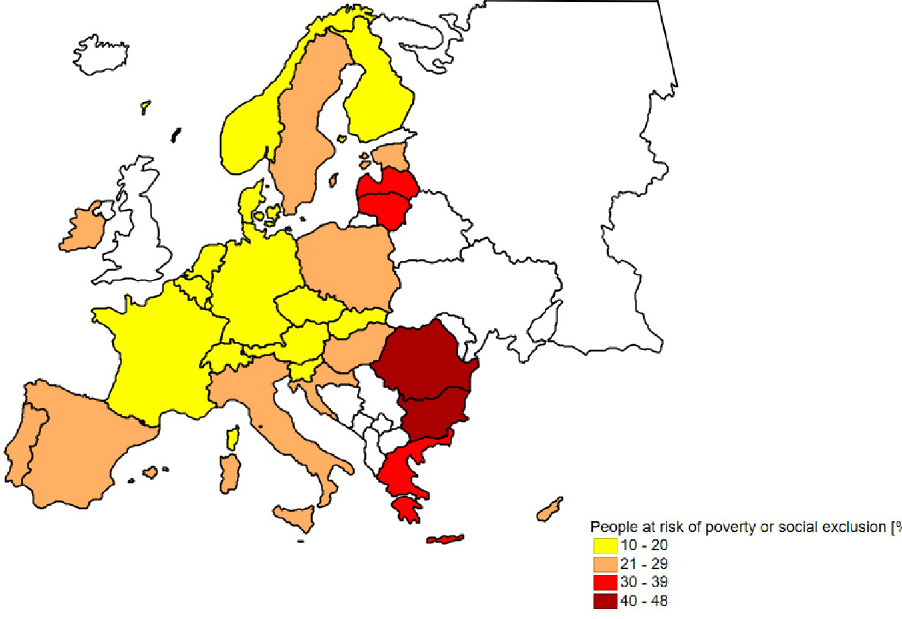
Fig 2. Share of people living in rural areas in UE-27 who are at risk of poverty or social exclusion in 2019 [44]. Source: Own elaboration base on